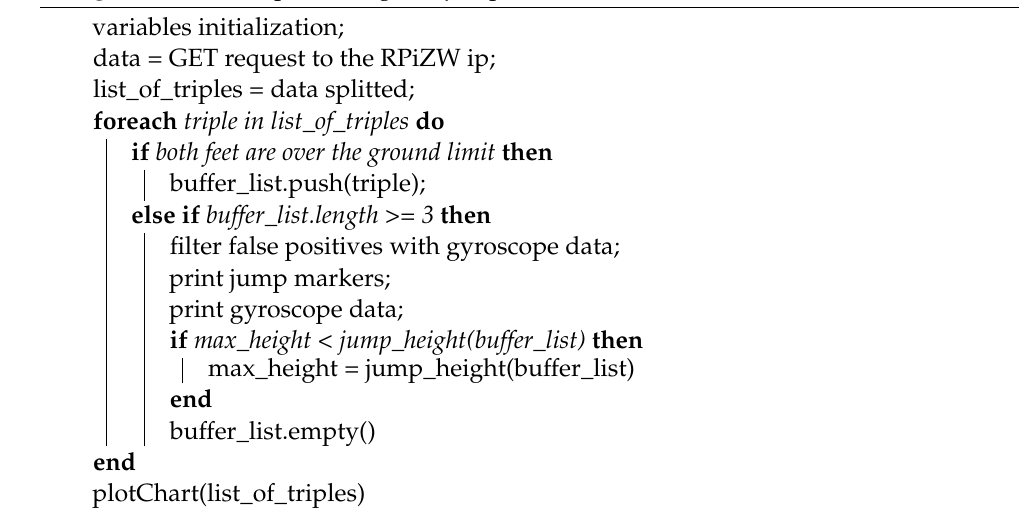
Algorithm 2: Data processing and jump